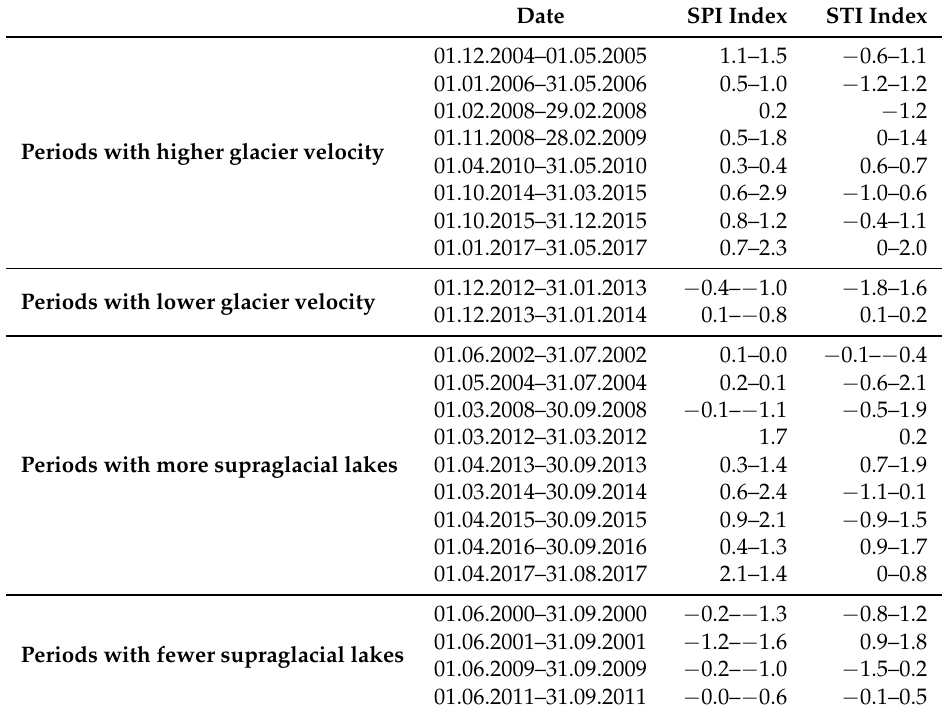
Table 5. SPI and STI indexes divided into phases with higher and lower glacier velocities and into fewer and more supraglacial